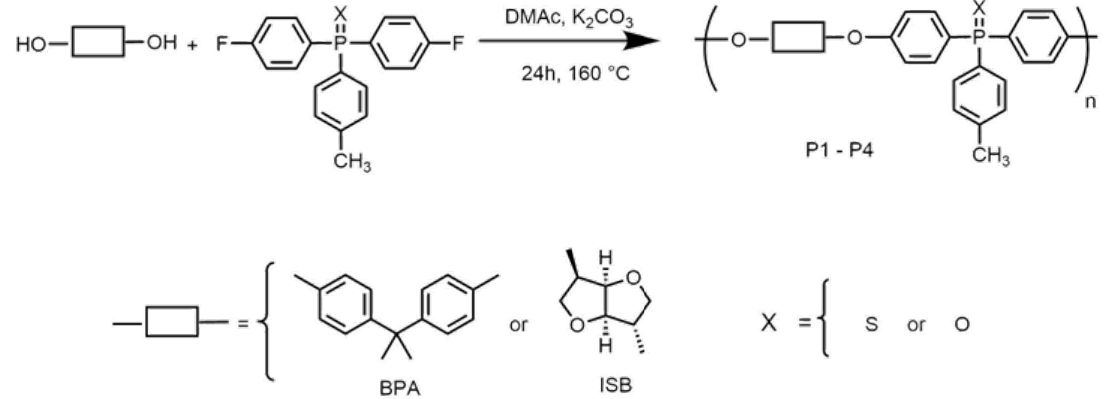
Figure 2. The synthetic routes of the poly(etherphosphine)s polymers P1–P4. (P1 = ISB and X = O/P2 = ISB and X = S/P3 = BPA and X = O/P4 = BPA and X = S).